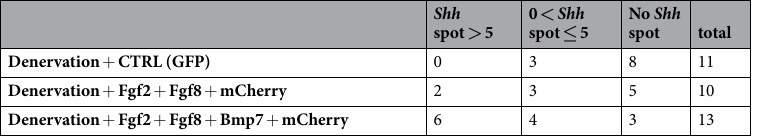
Table 1. Induction of Shh positive cells in the denervated mandible by regeneration